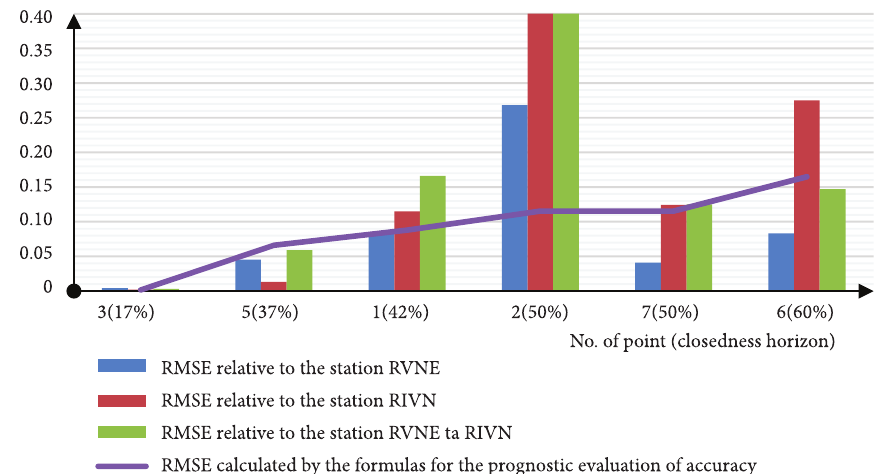
8. Comparison of RMSE of the height location by the session duration for 1 hour and prognostic points of accuracy evaluation calculated by Equation (12)